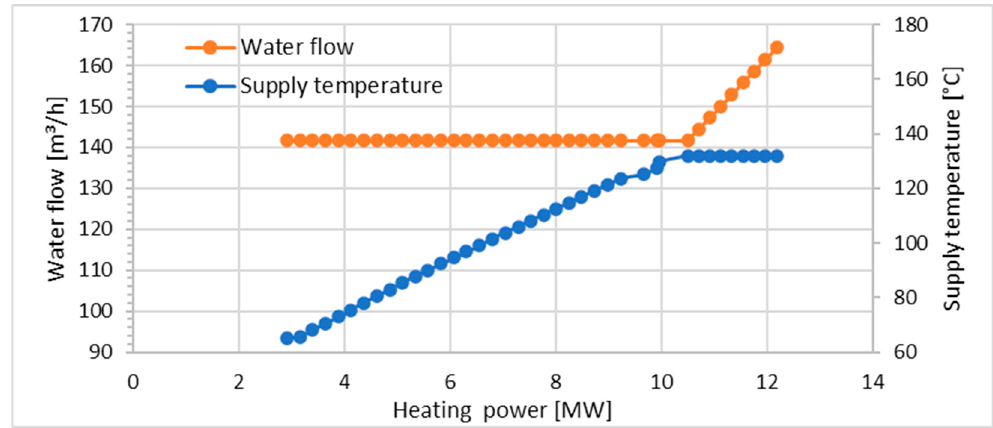
Figure 4. Control parameters of the heating plant.